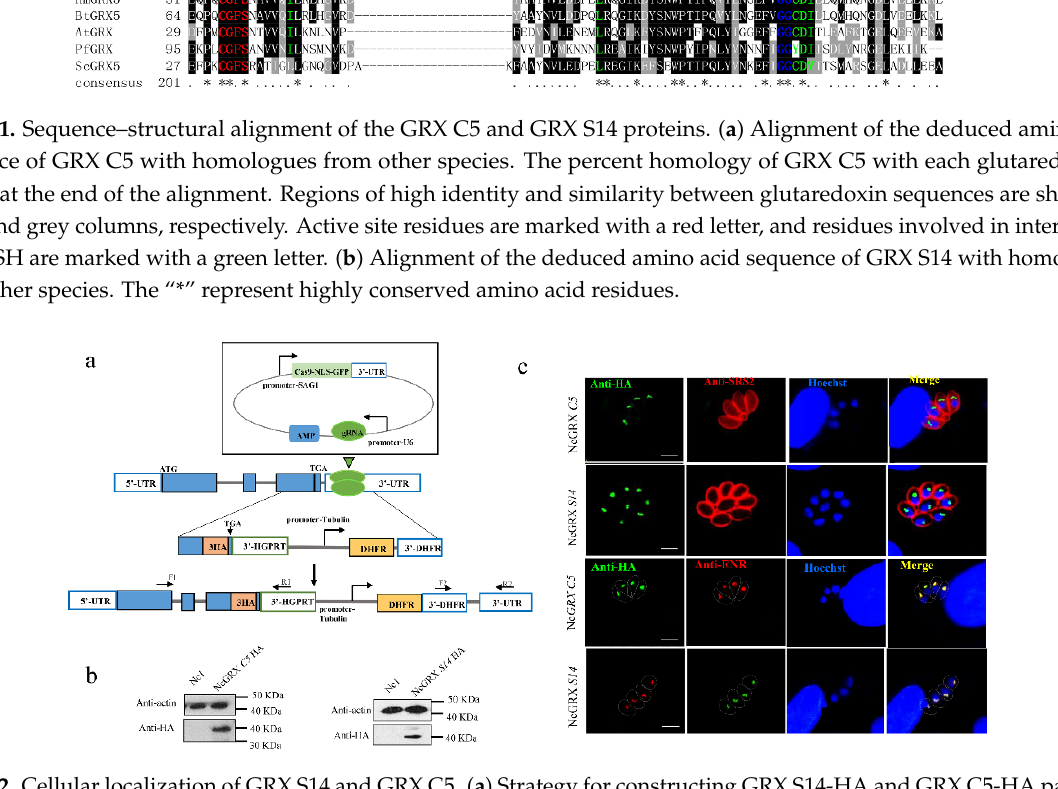
Figure 2. Cellular localization of GRX S14 and GRX C5. ( a ) Strategy for constructing GRX S14-HA and GRX C5-HA parasites. ( b ) Western blotting indicated that the HA tag was successfully added. α HA was used to detect GRX S14 and GRX C5; mouse anti-actin was used as a control. ( c ) IFA indicated GRX S14 and GRX C5 to both be distributed in the apicoplasts of parasites. α HA was used to detect GRX S14 and GRX C5 (green), whereas rabbit anti-SRS2 (red) served as a parasite surface marker. Rabbit anti-ENR (red) was used as an apicoplast marker, and the nuclear DNA was stained with Hoechst (blue) (bar = 5 μ m).